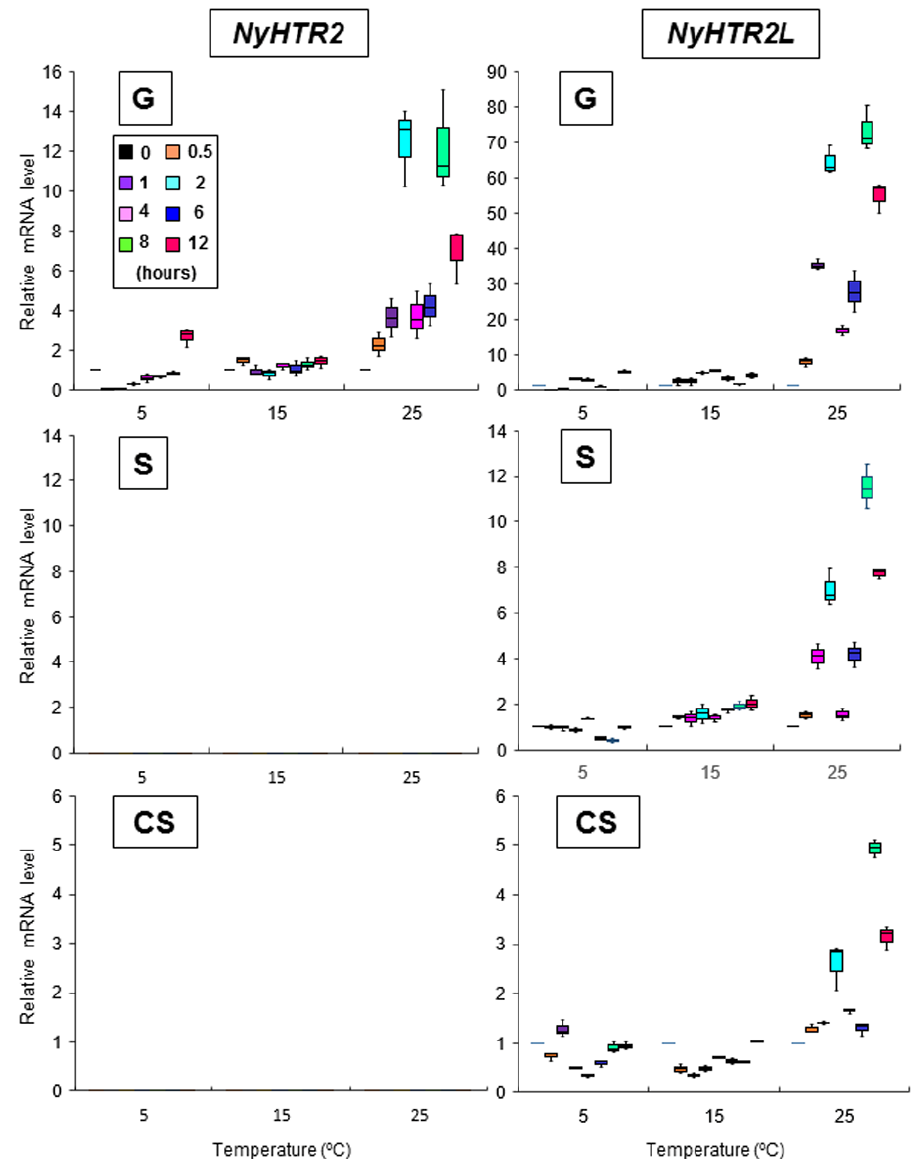
Figure 2. Temperature-dependent expression patterns of NyHTR2 and NyHTR2L with temporal comparisons over three life cycle generations of Neopyropia yezoensis . The relative mRNA levels were normalized using eIF4A as the reference gene. In the box plots, values on the Y axis represent the fold change of relative quantification of each gene. Since no expression of NyHTR2 was observed in sporophyte and conchosporophyte, nothing is displayed in corresponding panels in the figure. Significant differences in expression level among the three life cycle generations from triplicate independent replicates as defined by Tukey’s test ( p < 0.05) in two-way ANOVA are shown in Table S5. G—gametophyte; S—sporophyte;